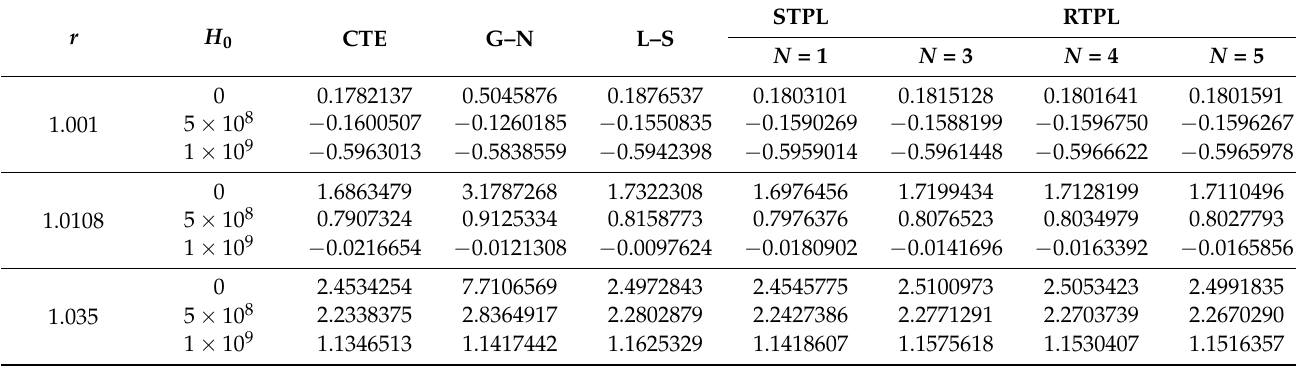
Table 6. Different thermoelasticity theories with a range of r values show the effects of dimensionless magnetic field intensity H 0 on volumetric strain e .